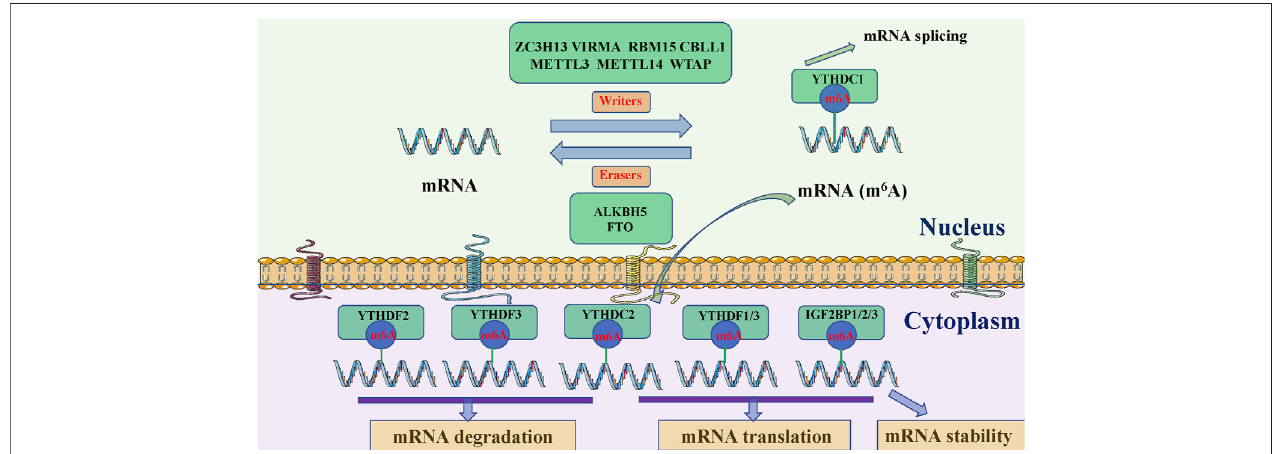
FIGURE 1 | Potential m6A methylation mechanisms in RNA. M6A methylation is catalyzed by the writer complex, including METTL3, METTL14, WTAP, VIRMA, RBM15, ZC3H13, and CBLL1. The demethylases, FTO and ALKBH5 remove m6A modi fi cations. Reader proteins (YTHDC1, YTHDF2, YTHDF3, YTHDC2, YTHDF1/3, and IGF2BP1/2/3) recognize m6A and determine target RNA targets. METTL3, methyltransferase 3, N6-adenosine-methyltransferase complex catalytic subunit; METTL14, methyltransferase 14, N6-adenosine-methyltransferase subunit; WTAP, WT1 associated protein; VIRMA, vir like m6A methyltransferase associated; RBM15, RNA binding motif protein 15; ZC3H13, zinc fi nger CCCH-type containing 13; CBLL1, Cbl proto-oncogene like 1; FTO, FTO α -ketoglutarate dependent dioxygenase; ALKBH5, alkB homolog 5, RNA demethylase; YTHDC1/2, YTH domain containing 1/2; YTHDF1/2/3, YTH N6-methyladenosine RNA binding protein 1/2/